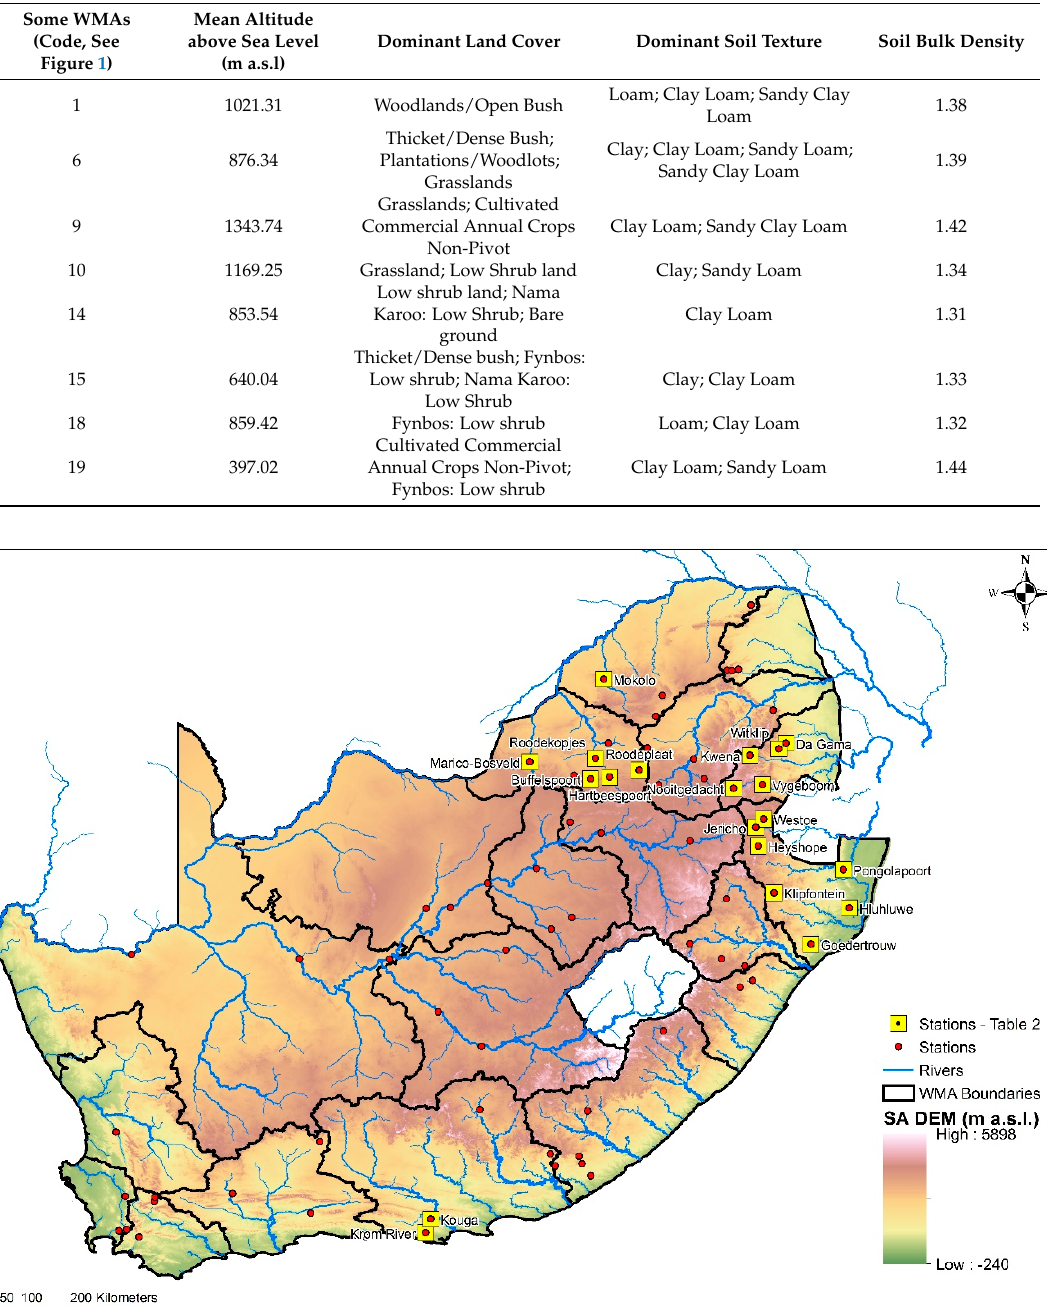
Table 1. Summary of some of the physiographic characteristics of Water Management Areas in South Africa. These physiographic characteristics refer to buffer zone (10 km radius) area characteristics averaged across the selected rainfall and streamflow stations within the Water Management Areas.